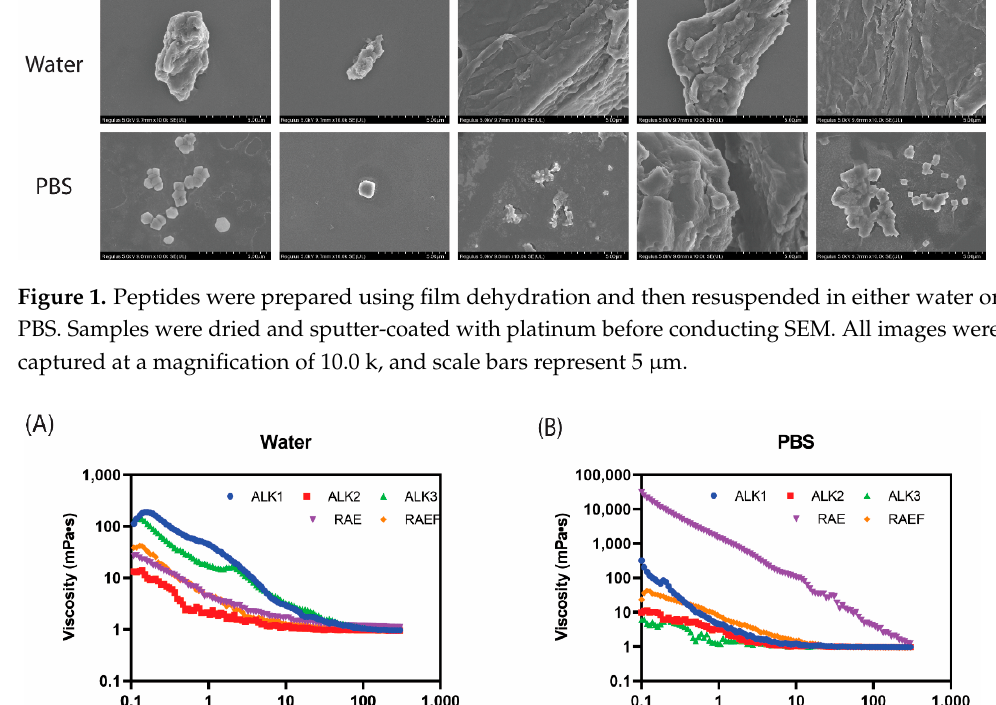
Figure 1. Peptides were prepared using film dehydration and then resuspended in either water or PBS . Samples were dried and sputter ‐ coated with platinum before conducting SEM. All images were captured at a magnification of 10.0 k, and scale bars represent 5 μ m.